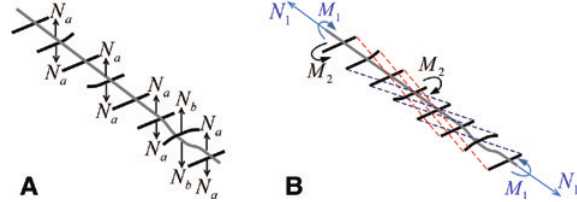
Figure 9: External load and interaction force of X and Y tows. (A) Interaction force between X and Y tows. (B) External load of X and Y